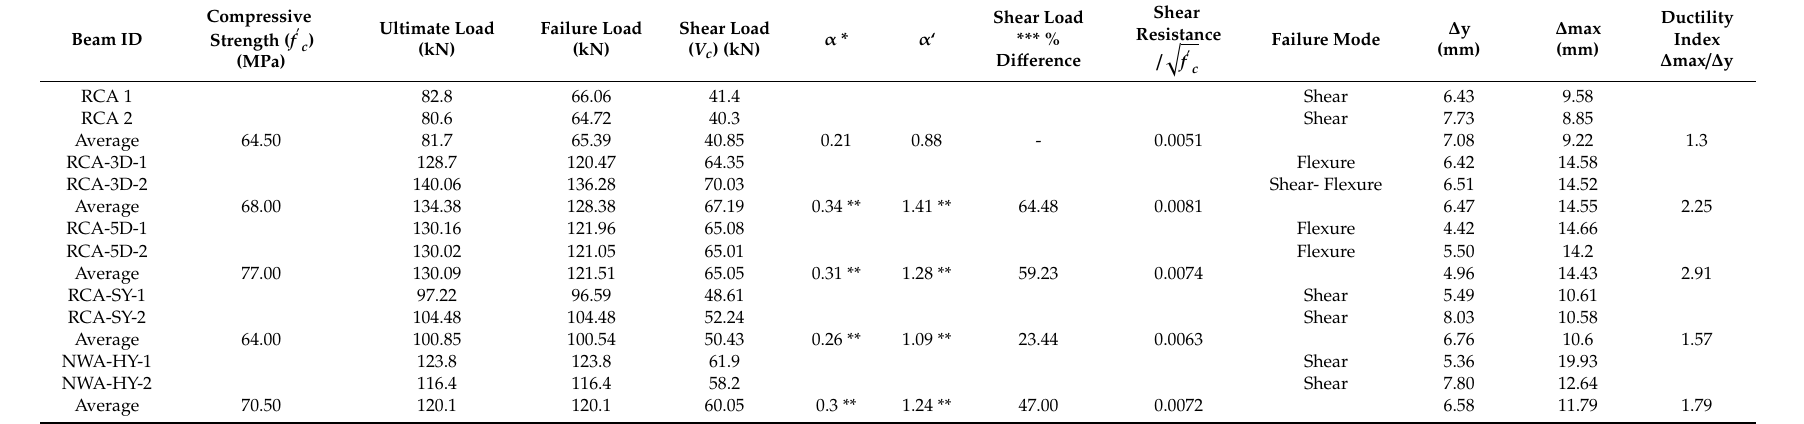
Table 10. Summary of the results for all